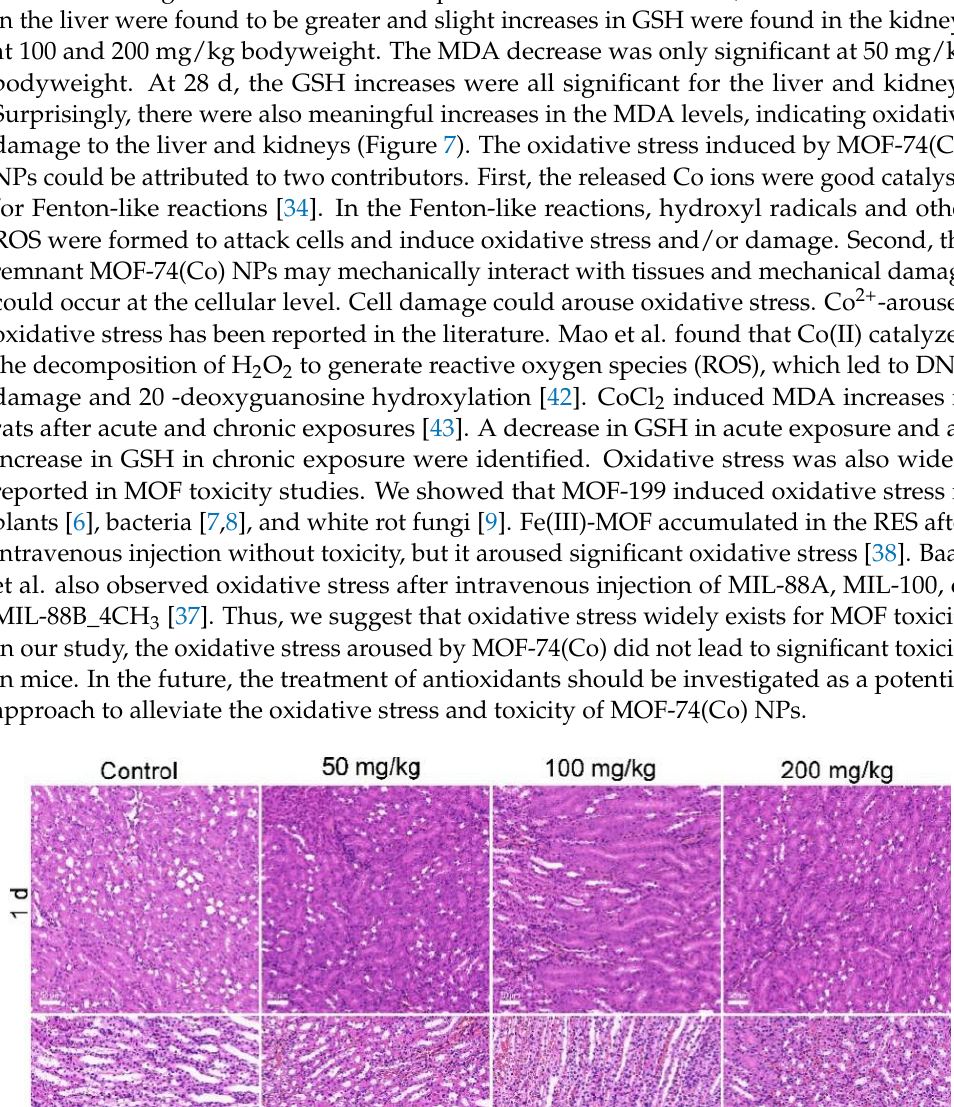
Figure 6. Histopathological observations of kidneys after exposure to MOF-74(Co). The scale bar represents 50 μ m.